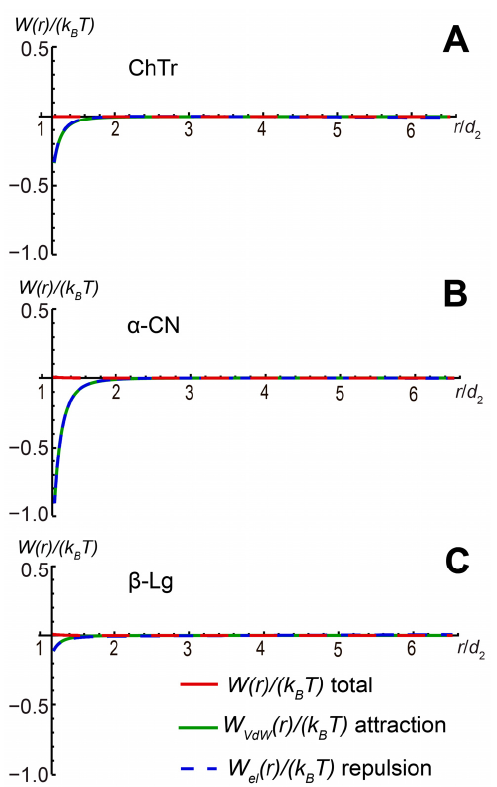
Figure 8. Total paired PPI potential and its contributing parts for ( A ) ChTr (pH = 3.5, I = 1.0 M); ( B ) α -CN (pH = 7.0, I = 0.1 M); ( C ) β -Lg (pH = 7.0, I =0.1 M). The β -Lg and α -CN self-association is highly dependent on the ionic strength ( I ) of the solution [68,73,125,126,129]. Furthermore, β -Lg at I = 0.1 M could form stable oligo- mers, leading to a decrease in the resulting weak non-specific PPI. In our opinion, the van teins. This effect is especially pronounced for α -CN. The main reason for this behavior is likely the non-electrostatic interactions between disordered fragments of its molecules. However, these intra-molecular interactions are relatively weak and unstable in solution. With a further increase in the salinity or due to other favorable factors, these attractive interactions lead to the formation of stable protein self-associates, as was observed for β - Lg [136,137]. 7. Conclusions PPIs have a pivotal role in biological processes in living systems, controlling and modulating the direction protein functioning, such as, for example, signal transduction, associated with various diseases, including cancer, infections, and neurodegenerative dis- eases [138]. In the present article, we analyzed the uniform approach to study intermolecular in- teractions of proteins in solutions. This approach is based on the analysis of the transla- tional diffusion data. It was applied to a set of the spheroidal proteins differing in degree of structural (dis)order. The reviewed approach carries out the inter-complementary anal- ysis of the protein self- and collective diffusion coefficients obtained by the experimental